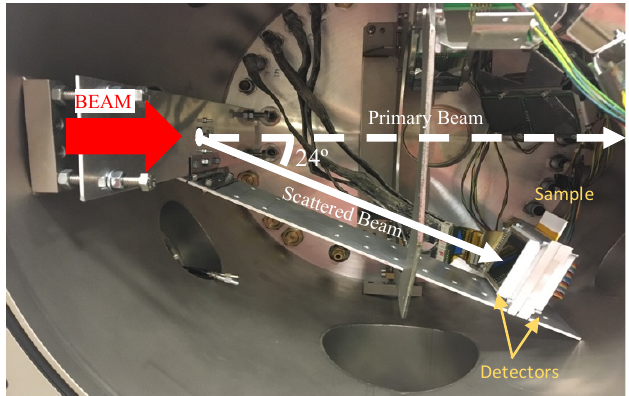
Fig. 2. Experimental setup used at the CMAM facility. The 10-MeV proton beam was scattered at a bismuth target. The detectors and sample were placed at 24º with respect to the primary beam direction. A close-up view on the detectors and sample area is shown in Fig. 3.